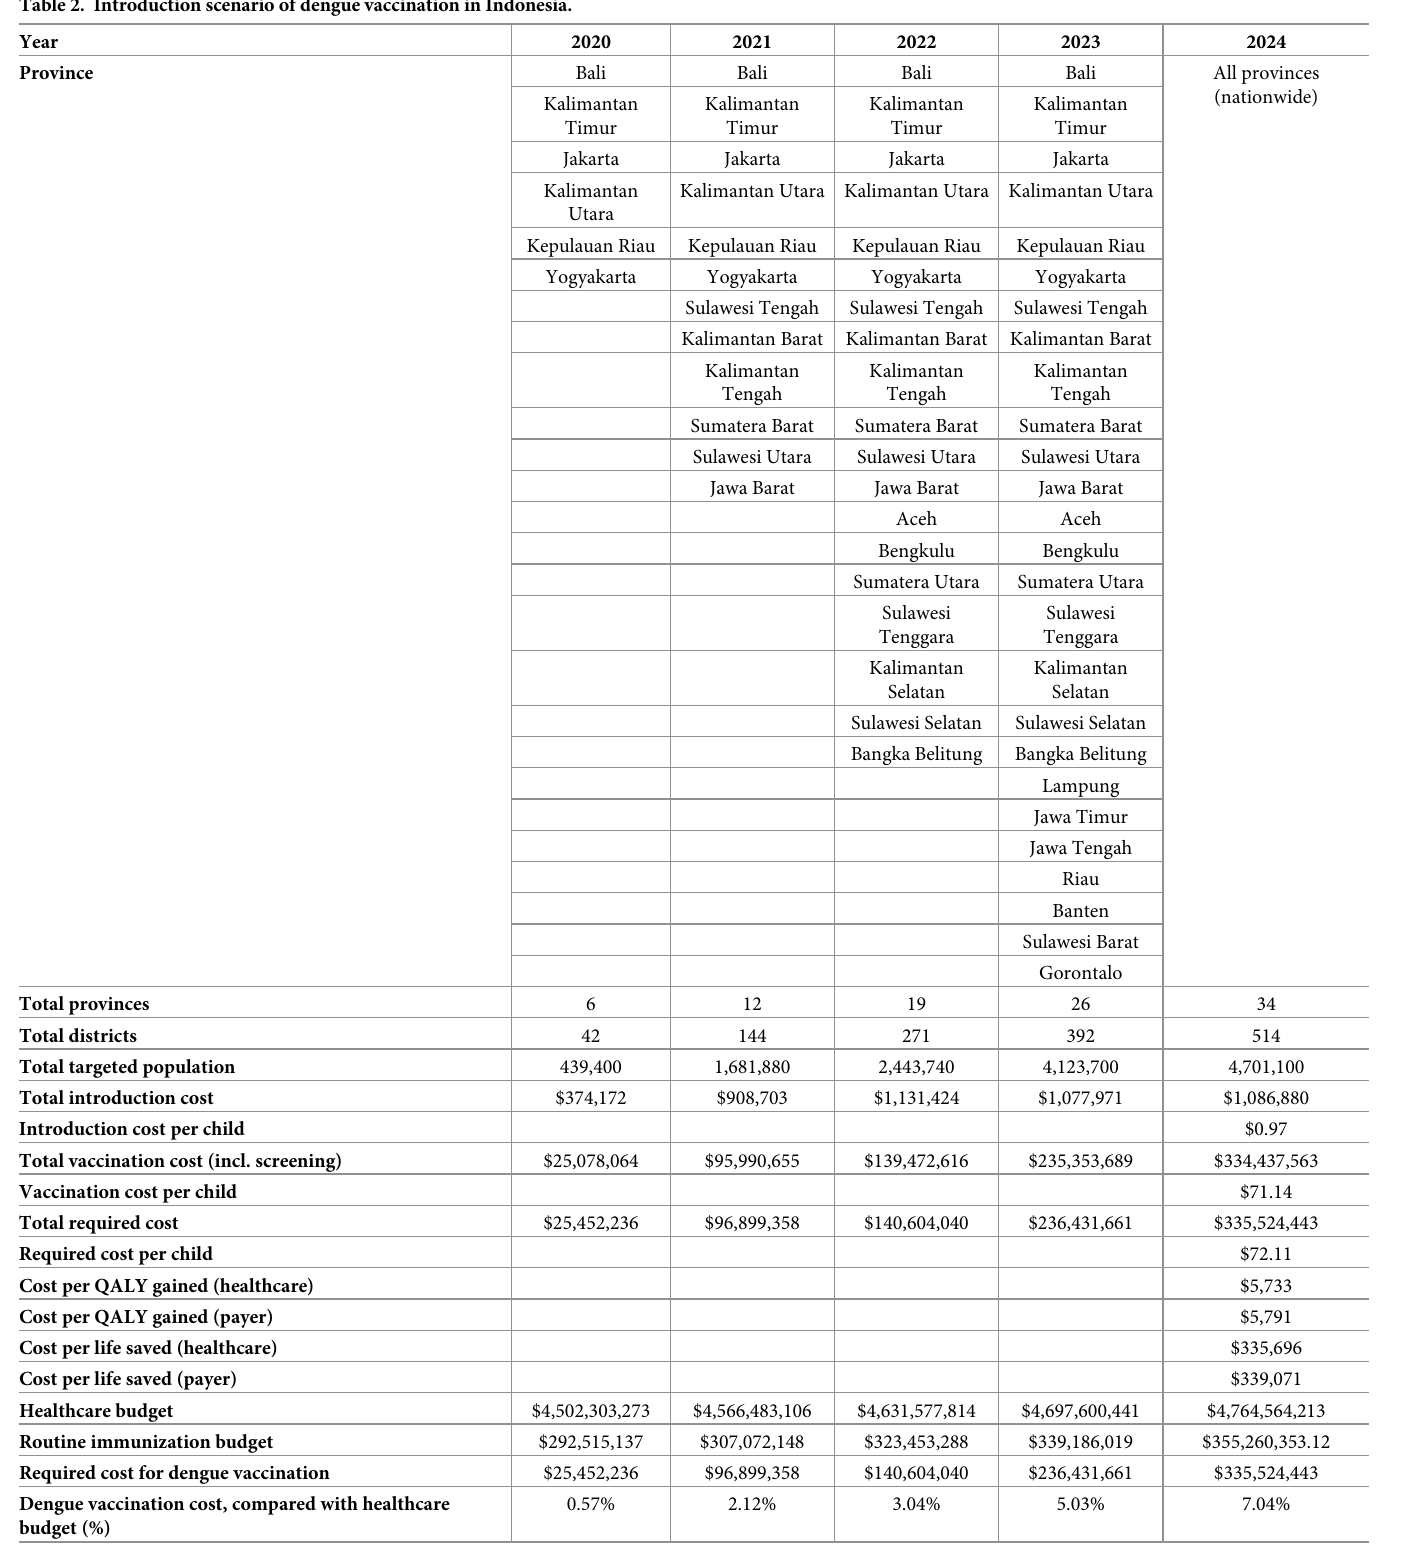
Table 2. Introduction scenario of dengue vaccination in